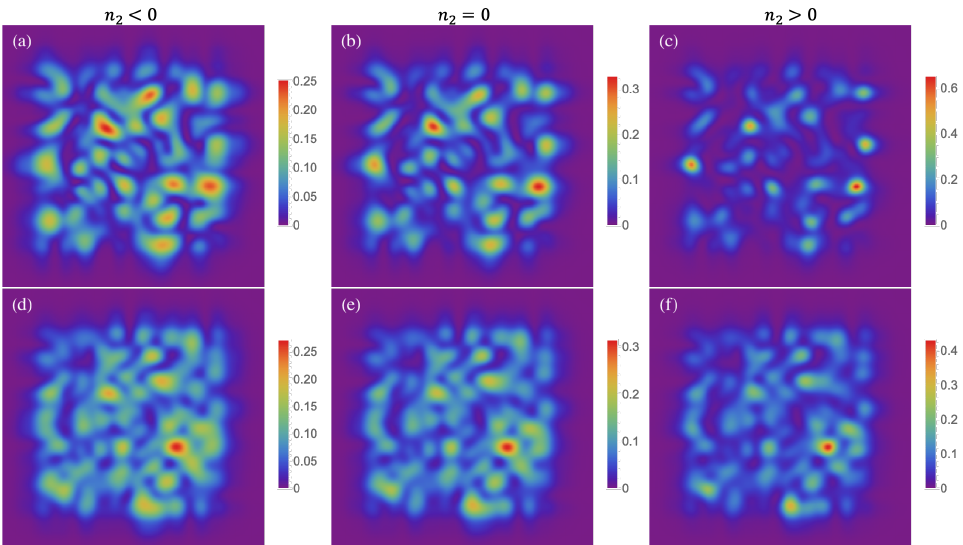
Figure 2. Speckle fields after propagation in a medium with ( a , d ) defocusing non- lineariry n 2 = − 3 × 10 − 16 cm 2 /W, ( b , e ) zero nonlinearity, and ( c , f ) focusing nonlineariry n 2 = 3 × 10 − 16 cm 2 /W. Note the different color scales as one goes from negative to positive n 2 . Parameters: L = 100 λ 0 , λ 0 = 800 nm, I 0 = 2.6 × 10 13 W/cm 2 , T = 100 fs, n 0 = 1.47, N = 3 ( a – c ) and N = 5 ( d – f ). In all of the cases, uniform illumination has been considered at the